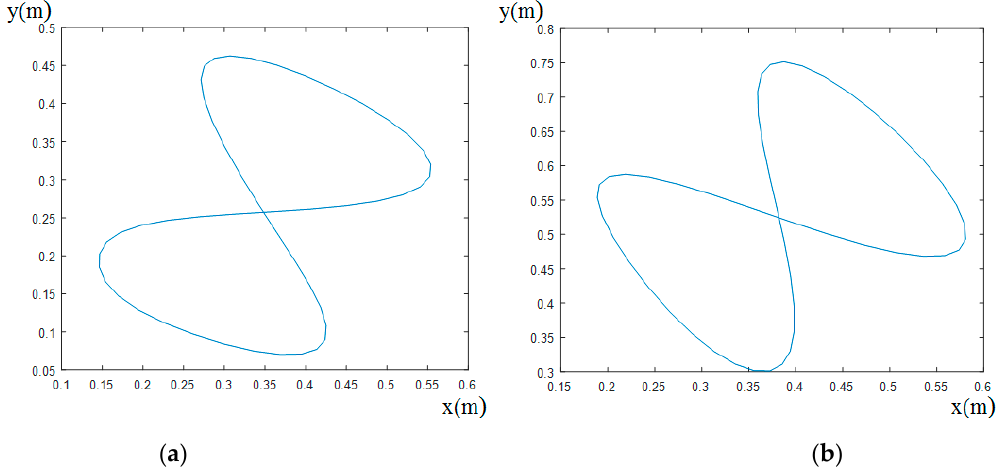
Figure 4. Locations of ( a ) optimal and ( b ) “bad” task placement within the UR-3 manipulator’s workspace.